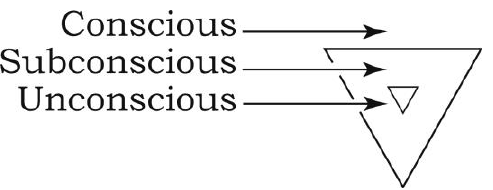
Figure 17: The Three-Consciousness Teaching Diagram The Existential Script